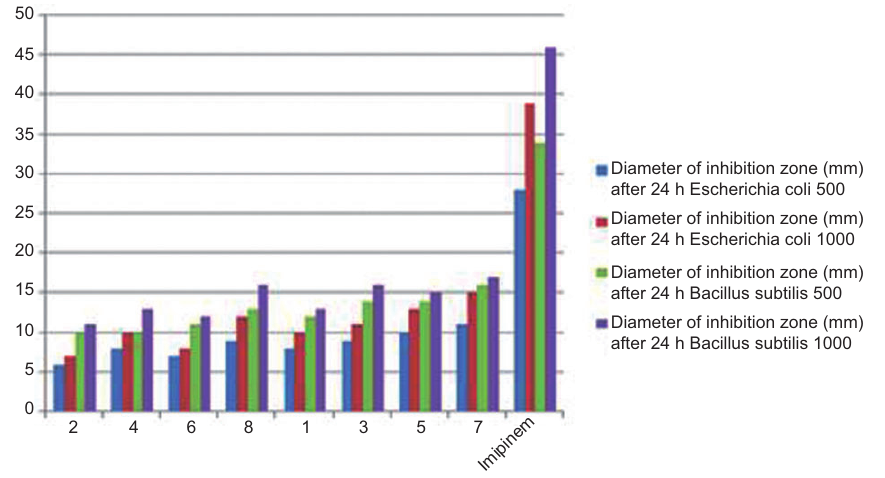
Graph 1 Antibacterial screening of the ligands and their